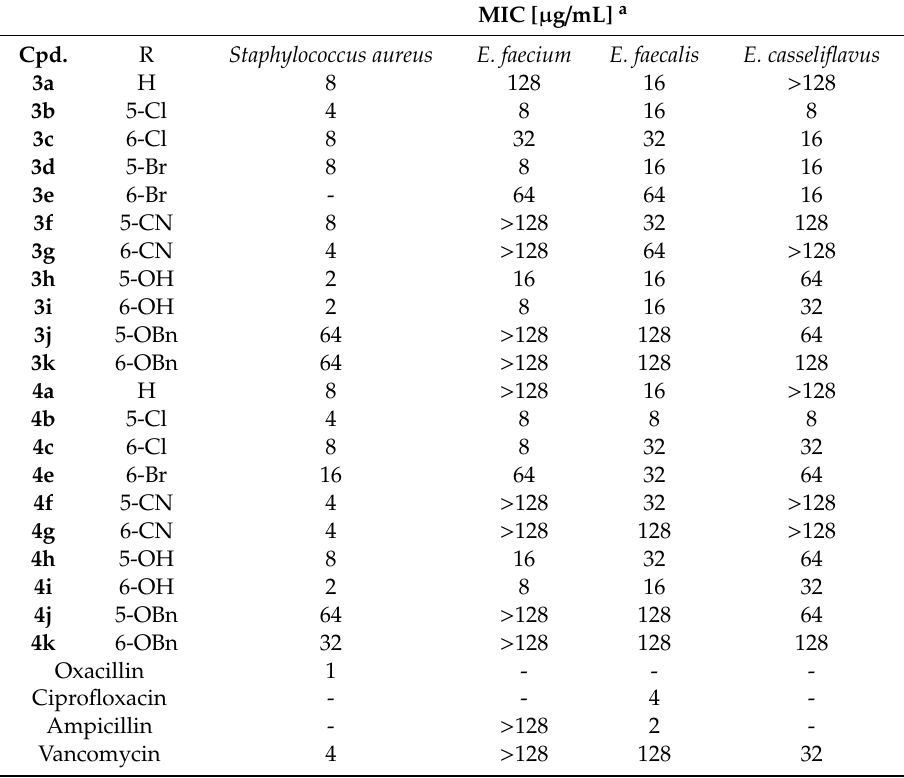
Table 1. Minimal inhibitory concentration (MIC) values determined for target compounds 3a – k and 4a – k in Staphylococcus aureus USA300 LAC* and Enterococcus